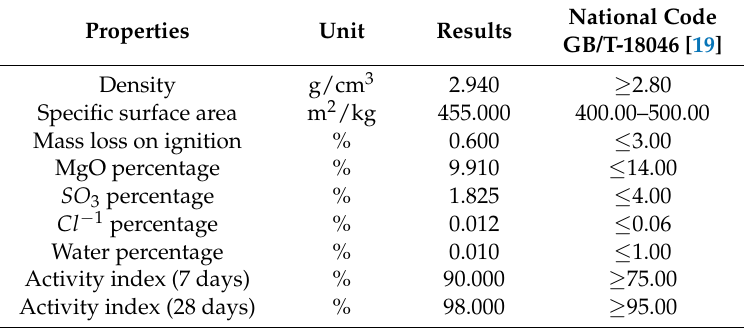
Table 3. Properties of ground granulated blast furnace slag